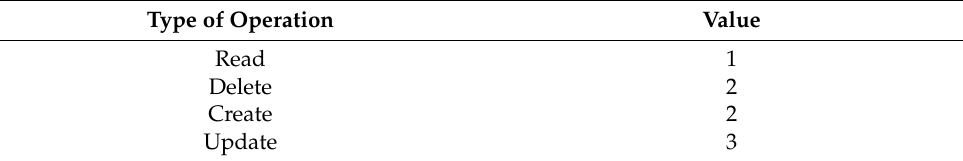
Table 2. Values for each type of